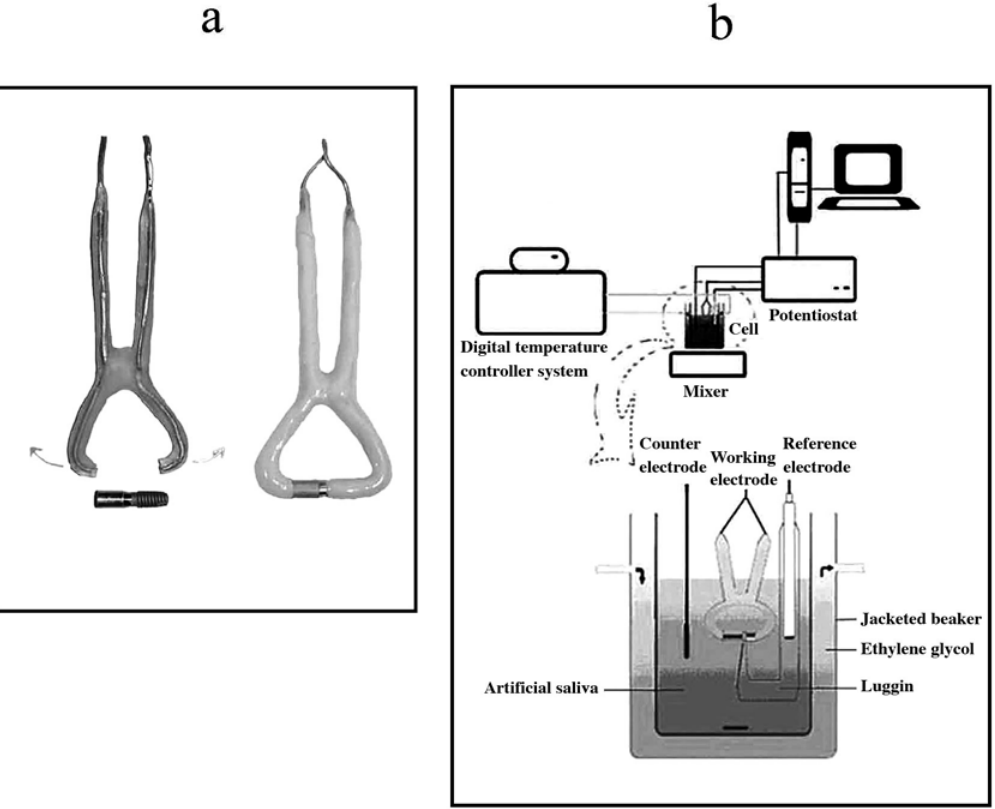
FIGURE 1- (a) Two tips open, flexible, copper clamp and covered sample with epoxy resin. (b) Schematic view of electrochemical cell and experiment set